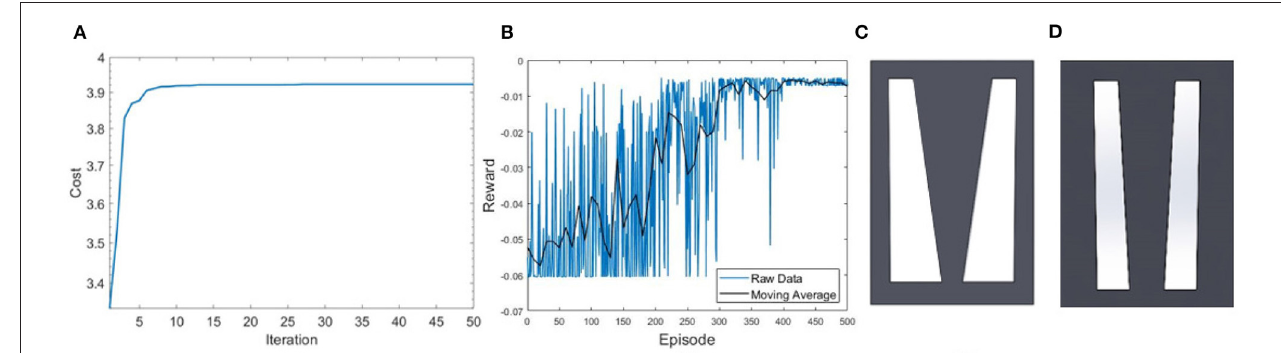
FIGURE 4 | Performance of convergence toward optimal solution for (A) FA, where the best cost is achieved in 10 iterations, and (B) DDPG algorithms, where steady region was achieved after 400 episodes with 10 points included in the moving average. (C) Optimized design from the FA optimization with an estimated horizontal displacement of 0.015 m . (D) Air chamber design from the DDPG based optimization at the steady state with model estimated displacement of 0.0103 m